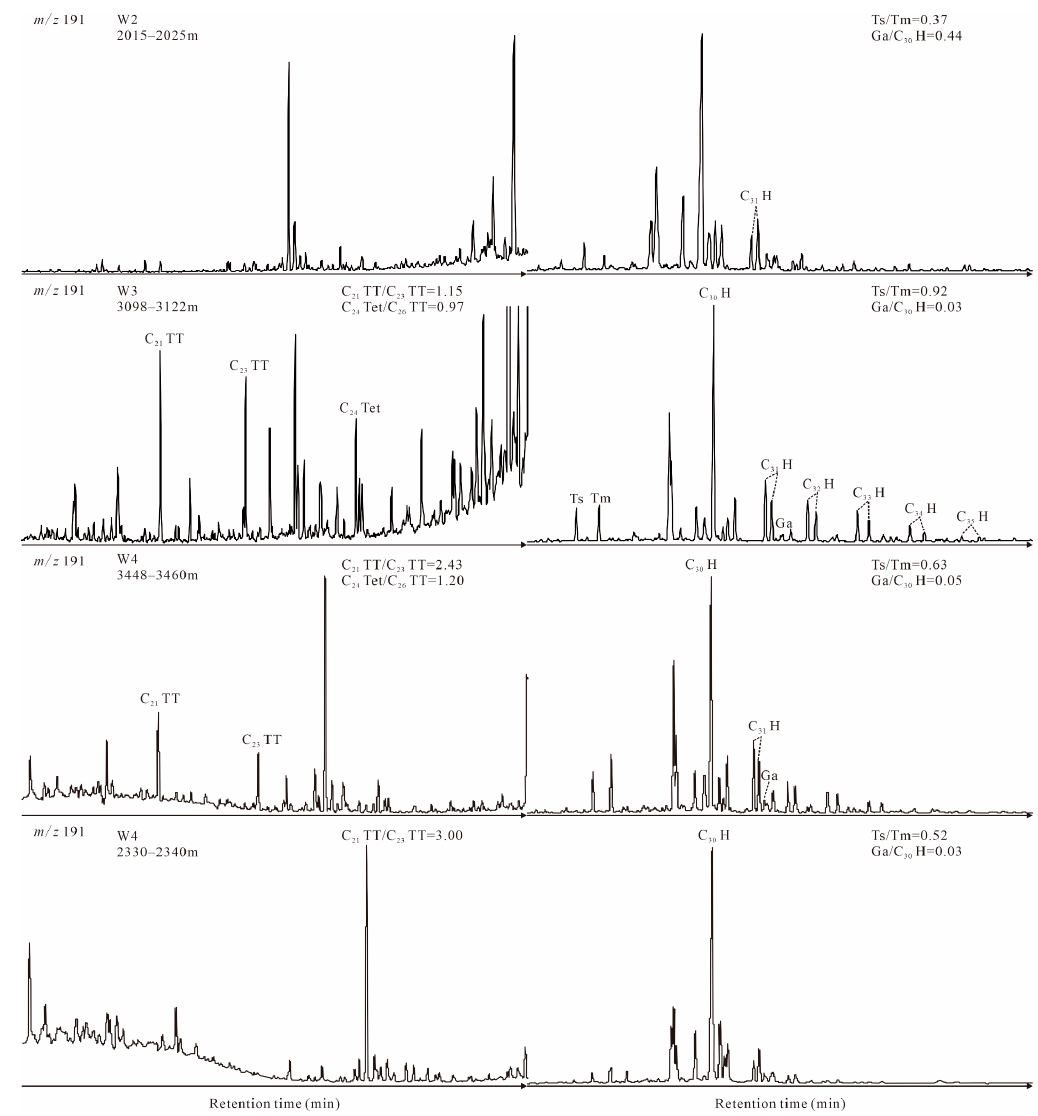
Figure 5. Selected m/z 191 mass fragmentograms for source rock samples from LS2 of the Weixinan Sag, Beibuwan Basin, showing the distribution of the terpane series. Sag, Beibuwan Basin, showing the distribution of the terpane